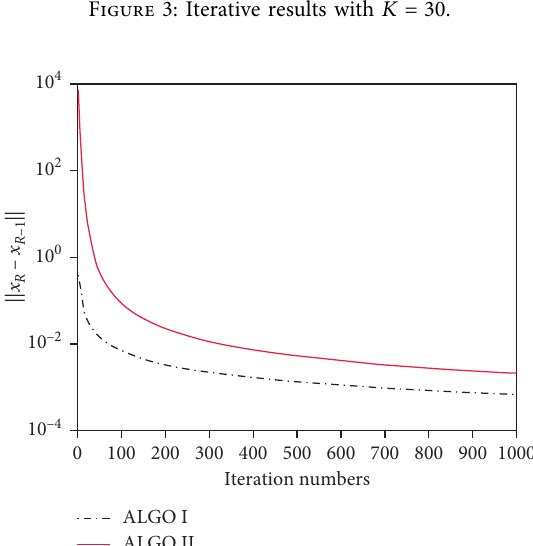
Figure 3: Iterative results with K � 30.